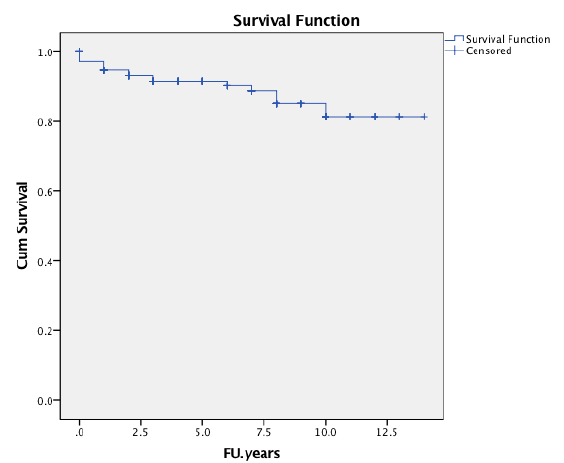
Figure 5. Kaplan-Meier implant survival curve with the endpoint of revision for any reason at the